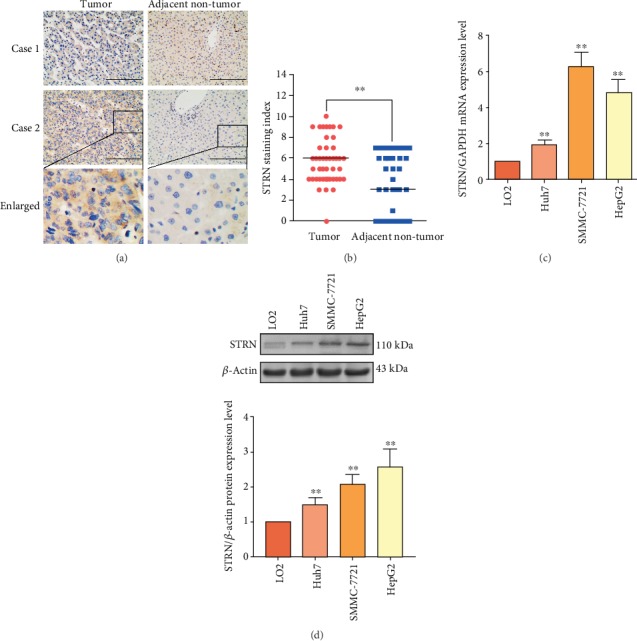
Expression of STRN in HCC tissues and cells. (a) Staining of STRN was performed by immunohistochemistry, and representative images from two cases are shown. Scale bars, 200 μm. (b) The staining index (SI) of STRN was significantly higher in HCC tissues than in ANT samples. (c) The mRNA expression level of STRN in the human normal liver cell line LO2 and the HCC cell lines Huh7, SMMC-7721, and HepG2 was measured by qRT-PCR. (d) The protein expression level of STRN in the human normal liver cell line LO2 and the HCC cell lines Huh7, SMMC-7721, and HepG2 was determined by Western blot analysis. ∗∗P < 0.01vs. Tumor (b) and LO2 (c, d).